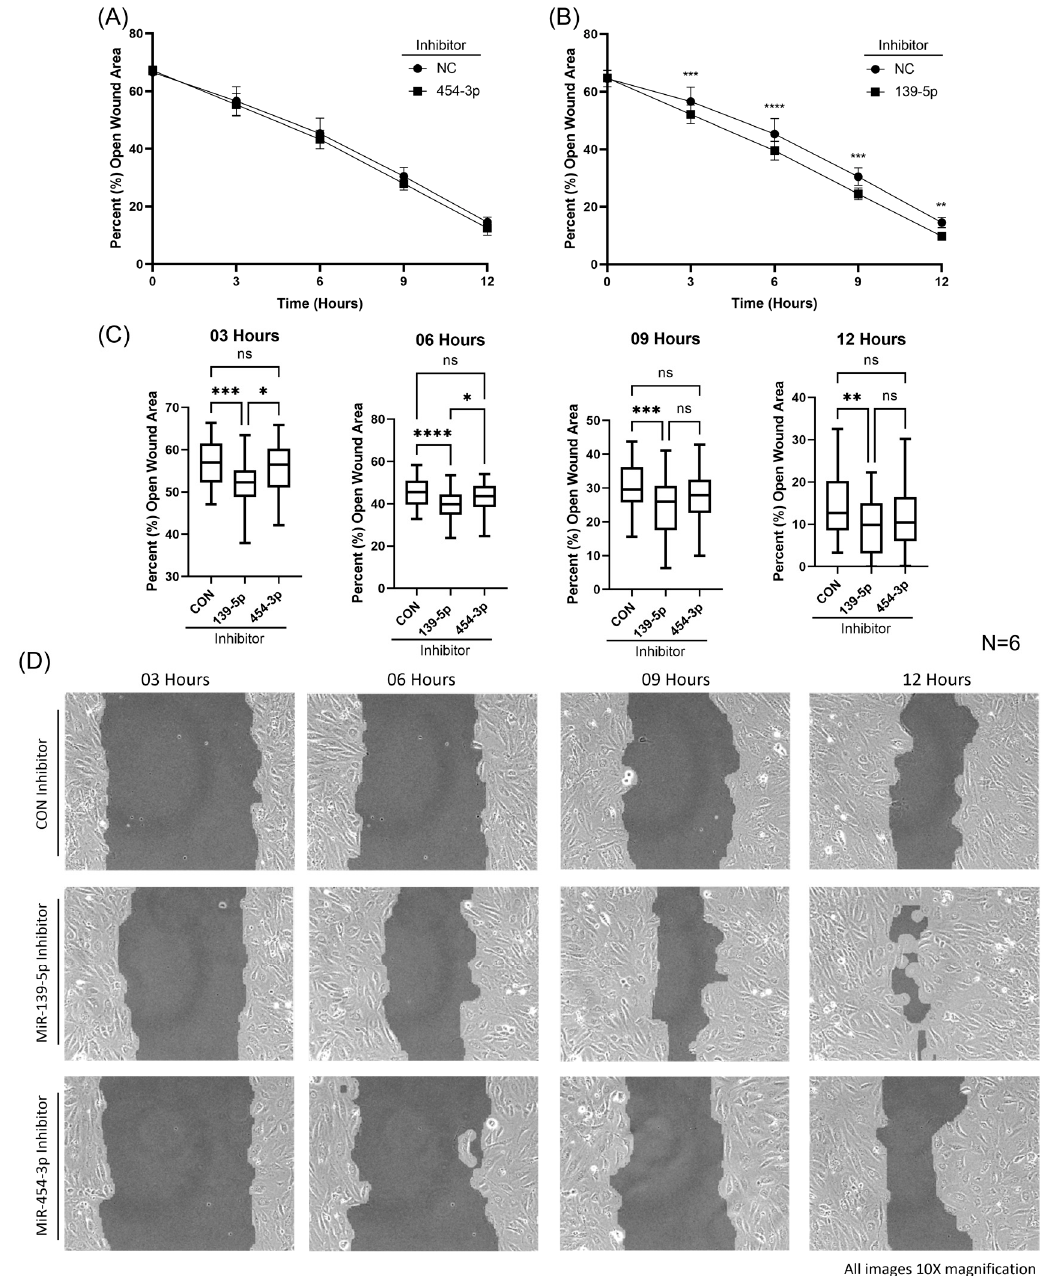
Figure 6. Measurement of HUVEC migration rates with an Ibidi wound healing assay. ( A ) The inhibition of miR-454-3p had no effect on HUVEC migration as shown by the percentage (%) of open wound area compared with that in negative controls (N = 6). ( B ) The inhibition of miR-139-5p resulted in significantly increased rates of migration as determined by the percentage (%) of open wound area compared with that in negative controls (N = 6). ( C ) Box plots display significant differences in HUVEC migration rates with miR-139-5p inhibition at 3, 6, 9 and 12 h measured by percentage (%) of open wound area. ( D ) Images of HUVEC migration with miR-139-5p inhibition, miR-454-3p inhibition and negative control inhibitors at 3, 6, 9 and 12 h (10 × magnification). ns: not significant, * p < 0.05, ** p < 0.01, *** p < 0.001, **** p < 0.0001.